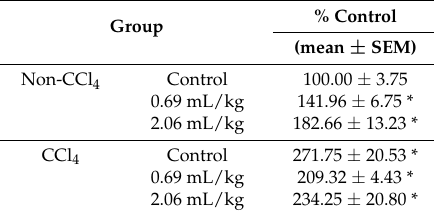
% Control Group (mean ± SEM) Non-CCl 4 Control 100.00 ± 3.75 0.69 mL/kg